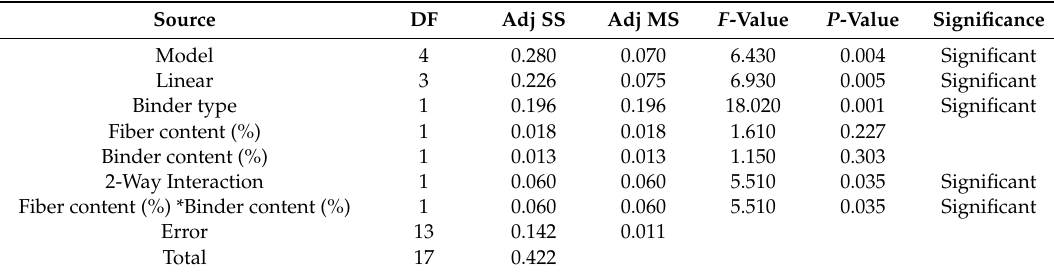
Figure 13. Comparison between the calculated CCC response and the predicted model. Table 12. Analysis of variance of the regression model developed for CCC .